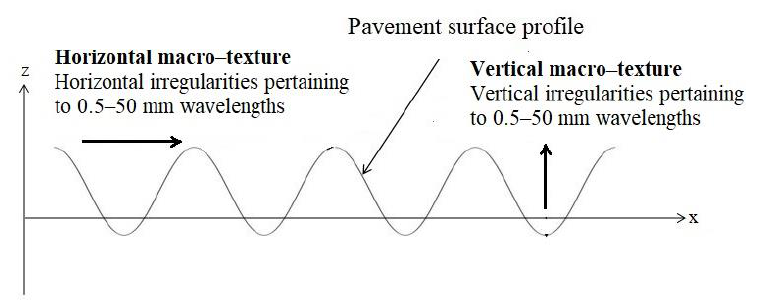
Figure 5. Schematic diagram of pavement macro-texture